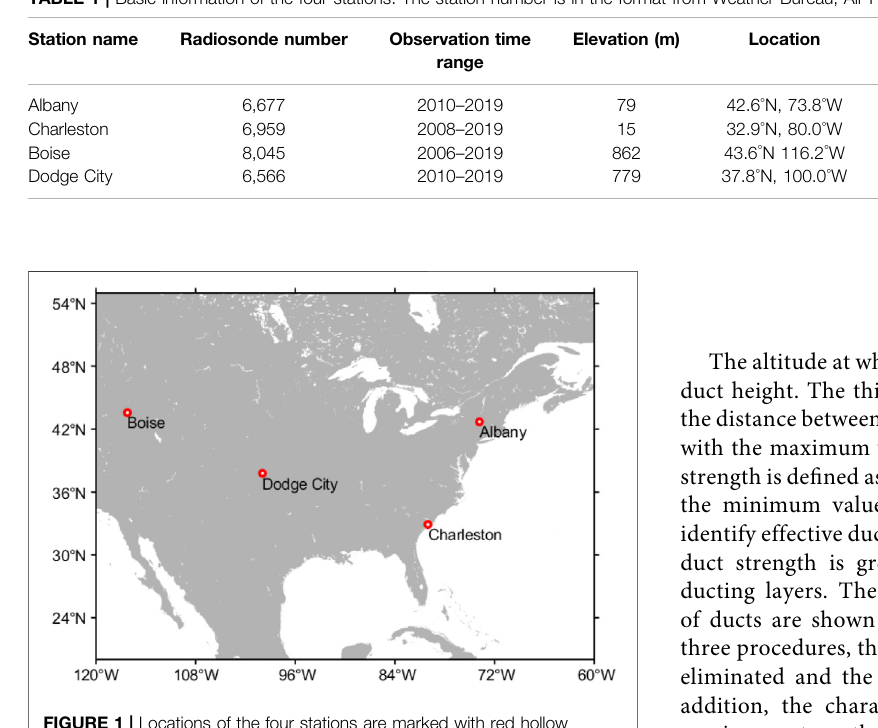
FIGURE 1 | Locations of the four stations are marked with red hollow circles in American